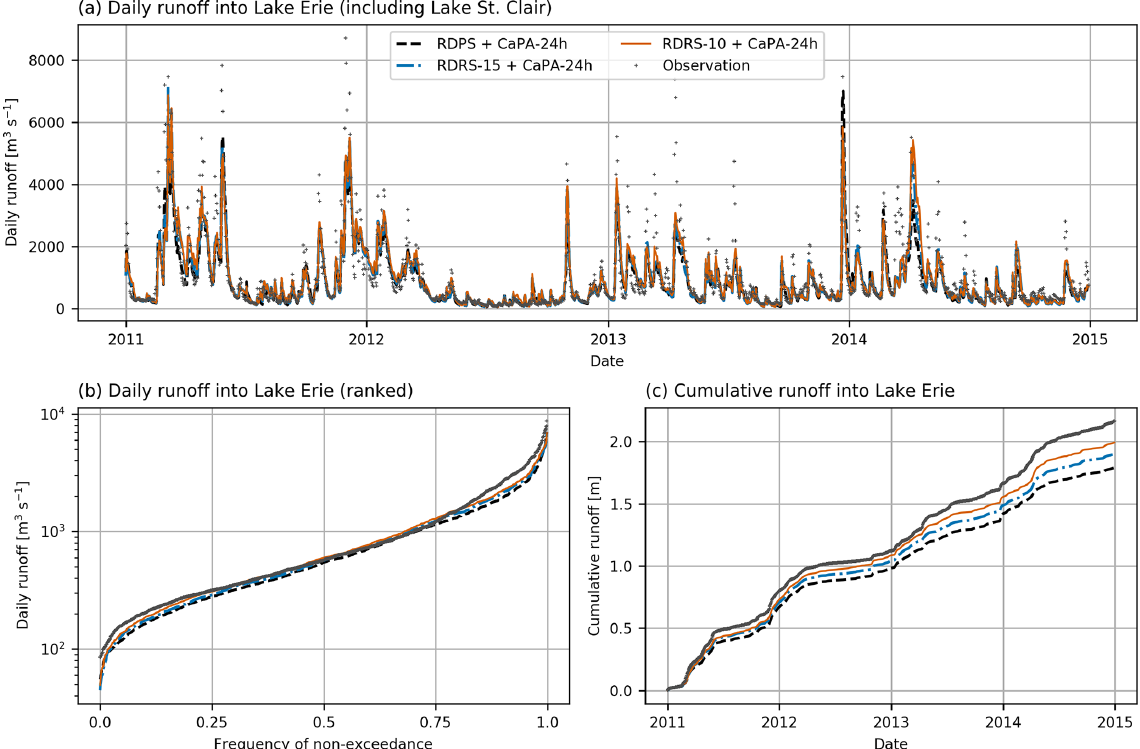
Figure 10. Comparison to observed Lake Erie inflows (grey dots) of GEM-Hydro simulations based on RDRS-10 + CaPA-24h (continuous orange line), RDRS-15 + CaPA-24h (dashed–dotted blue line) and RDPS + CaPA-24h (dashed black line) forcing for years 2011–2014: (a) daily inflows [m 3 s − 1 ]; (b) ranked daily inflows, log scale [m 3 s − 1 ]; and (c) cumulative inflow over the 5-year period